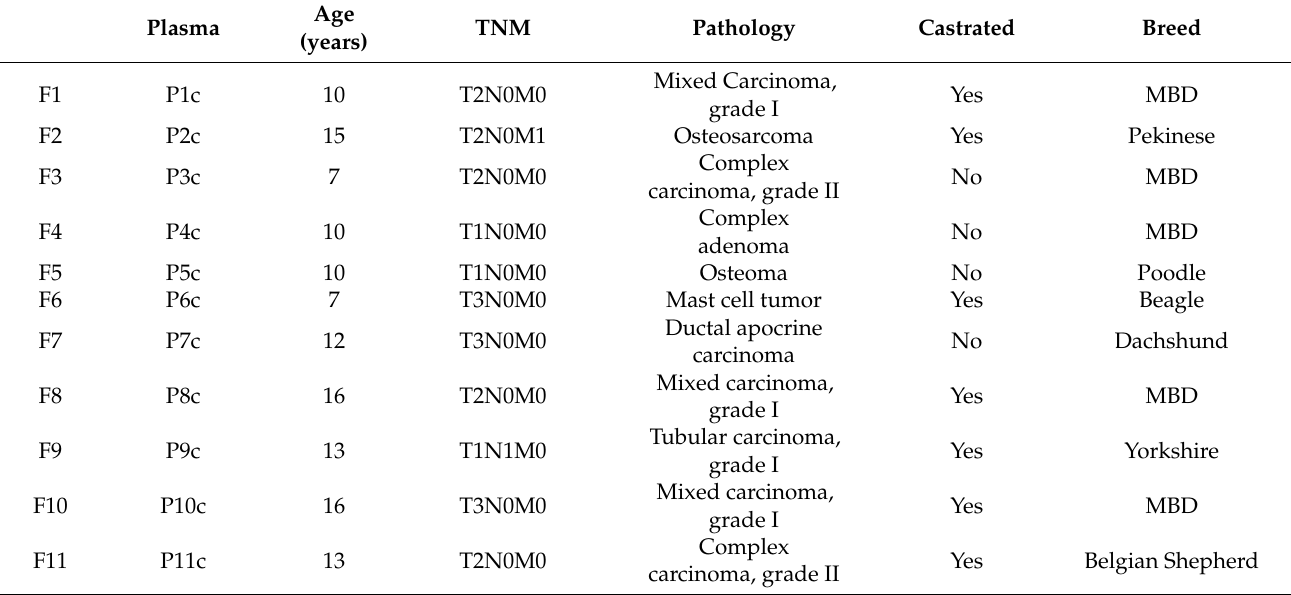
Table 5. Histopathological and clinical data of female dogs with newly diagnosed BC.